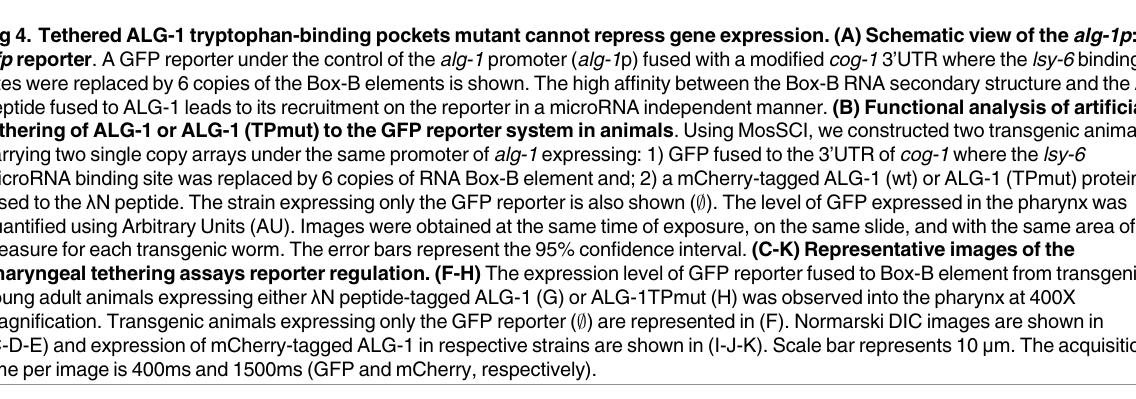
Fig 4. Tethered ALG-1 tryptophan-binding pockets mutant cannot repressgene expression. (A) Schematic view of the alg-1p :: gfp reporter . A GFP reporter under the control of the alg-1 promoter( alg-1 p)fused with a modified cog-1 3’UTR where the lsy-6 binding sites were replacedby 6 copies of the Box-B elementsis shown. The high affinity betweenthe Box-B RNA secondary structure and the λ N peptidefused to ALG-1 leads to its recruitment on the reporter in a microRNAindependentmanner. (B) Functional analysis of artificial tethering of ALG-1 or ALG-1 (TPmut) to the GFP reporter systemin animals . Using MosSCI, we constructed two transgenic animals carrying two single copy arrays under the same promoter of alg-1 expressing: 1) GFP fused to the 3’UTR of cog-1 where the lsy-6 microRNAbindingsite was replacedby 6 copies of RNA Box-B elementand; 2) a mCherry-tagged ALG-1 (wt) or ALG-1 (TPmut) protein fused to the λ N peptide. The strain expressingonly the GFP reporter is also shown ( ; ). The level of GFP expressedin the pharynxwas quantifiedusing Arbitrary Units (AU). Images were obtained at the same time of exposure,on the same slide, and with the same area of measurefor each transgenic worm. The error bars represent the 95% confidenceinterval. (C-K) Representative images of the pharyngeal tethering assaysreporter regulation. (F-H) The expressionlevel of GFP reporter fused to Box-B elementfrom transgenic young adult animals expressingeither λ N peptide-tagged ALG-1 (G) or ALG-1TPmut (H) was observedinto the pharynxat 400X magnification. Transgenic animalsexpressingonly the GFP reporter ( ; ) are represented in (F). Normarski DIC images are shown in (C-D-E) and expressionof mCherry-tagged ALG-1 in respective strains are shown in (I-J-K). Scale bar represents10 μ m. The acquisition time per image is 400ms and 1500ms (GFP and mCherry,